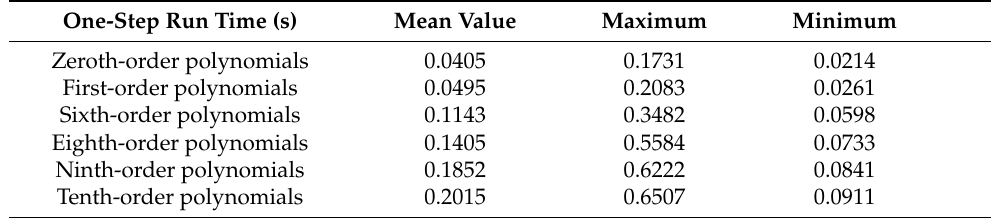
Table 3. Comparison of the one-step run